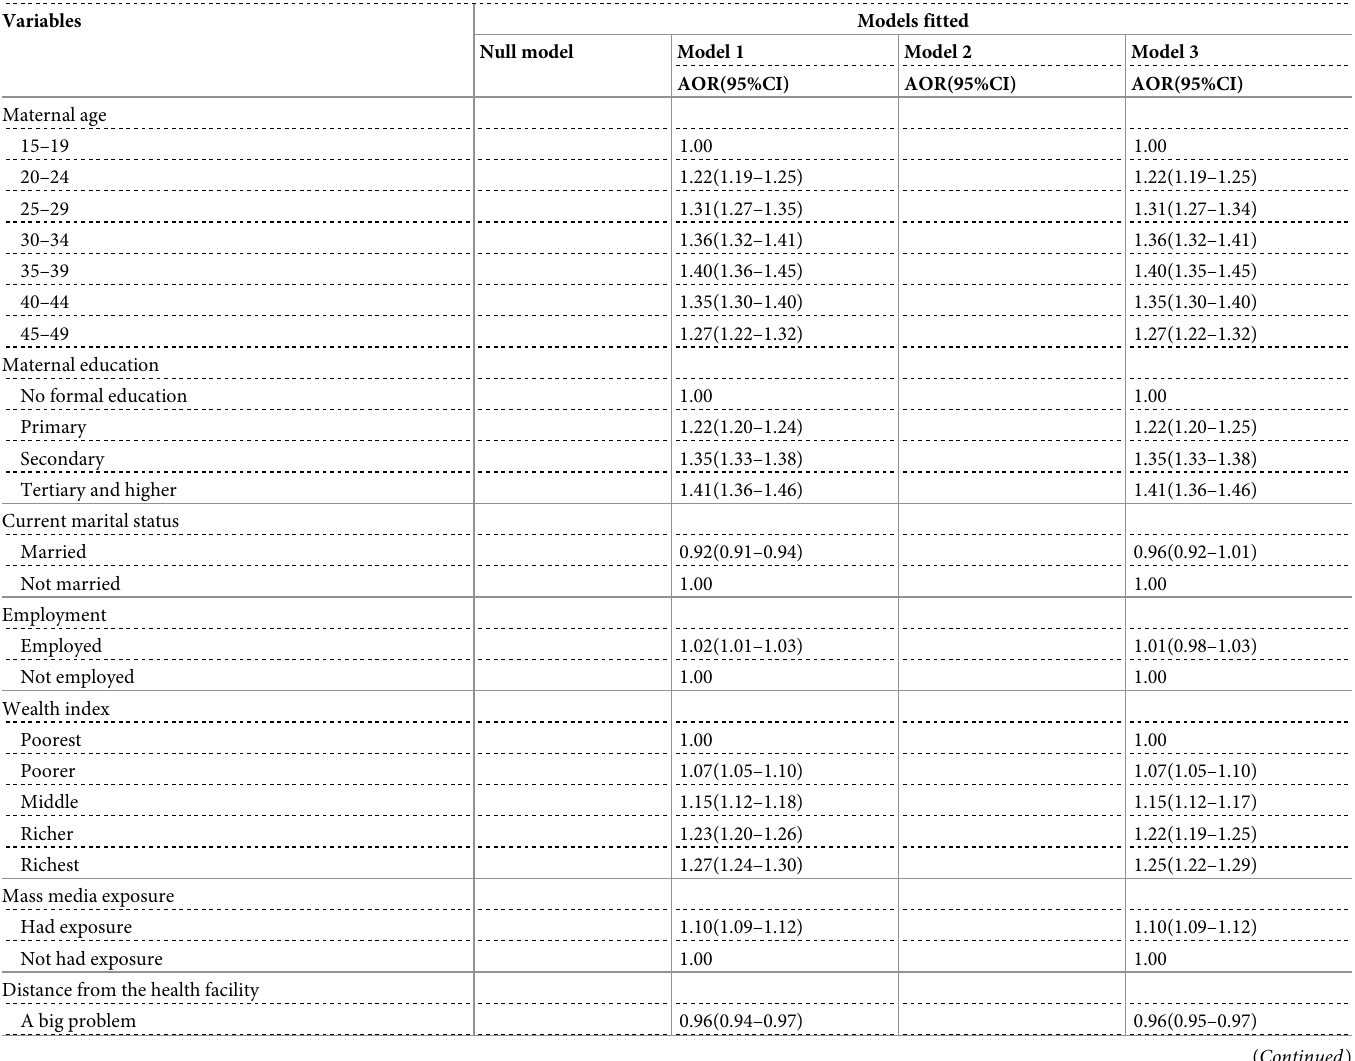
Table 4. Multilevel analysis of factors associated with knowledge about MTCT of HIV/AIDS and its prevention among reproductive-age women in